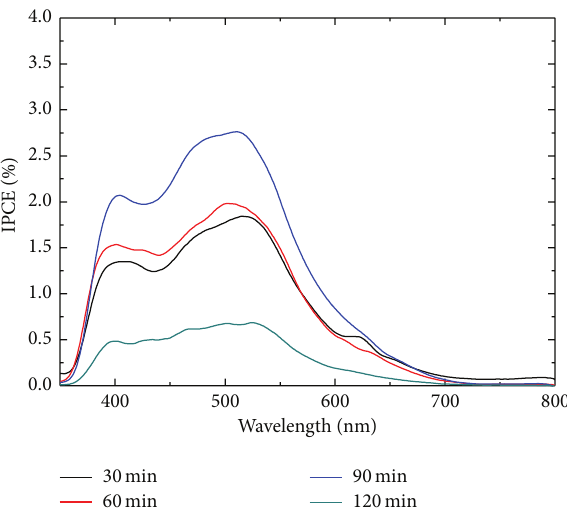
Figure 3: UV-visible spectra of DSSCs with the ZnO nanowires grown for different time.